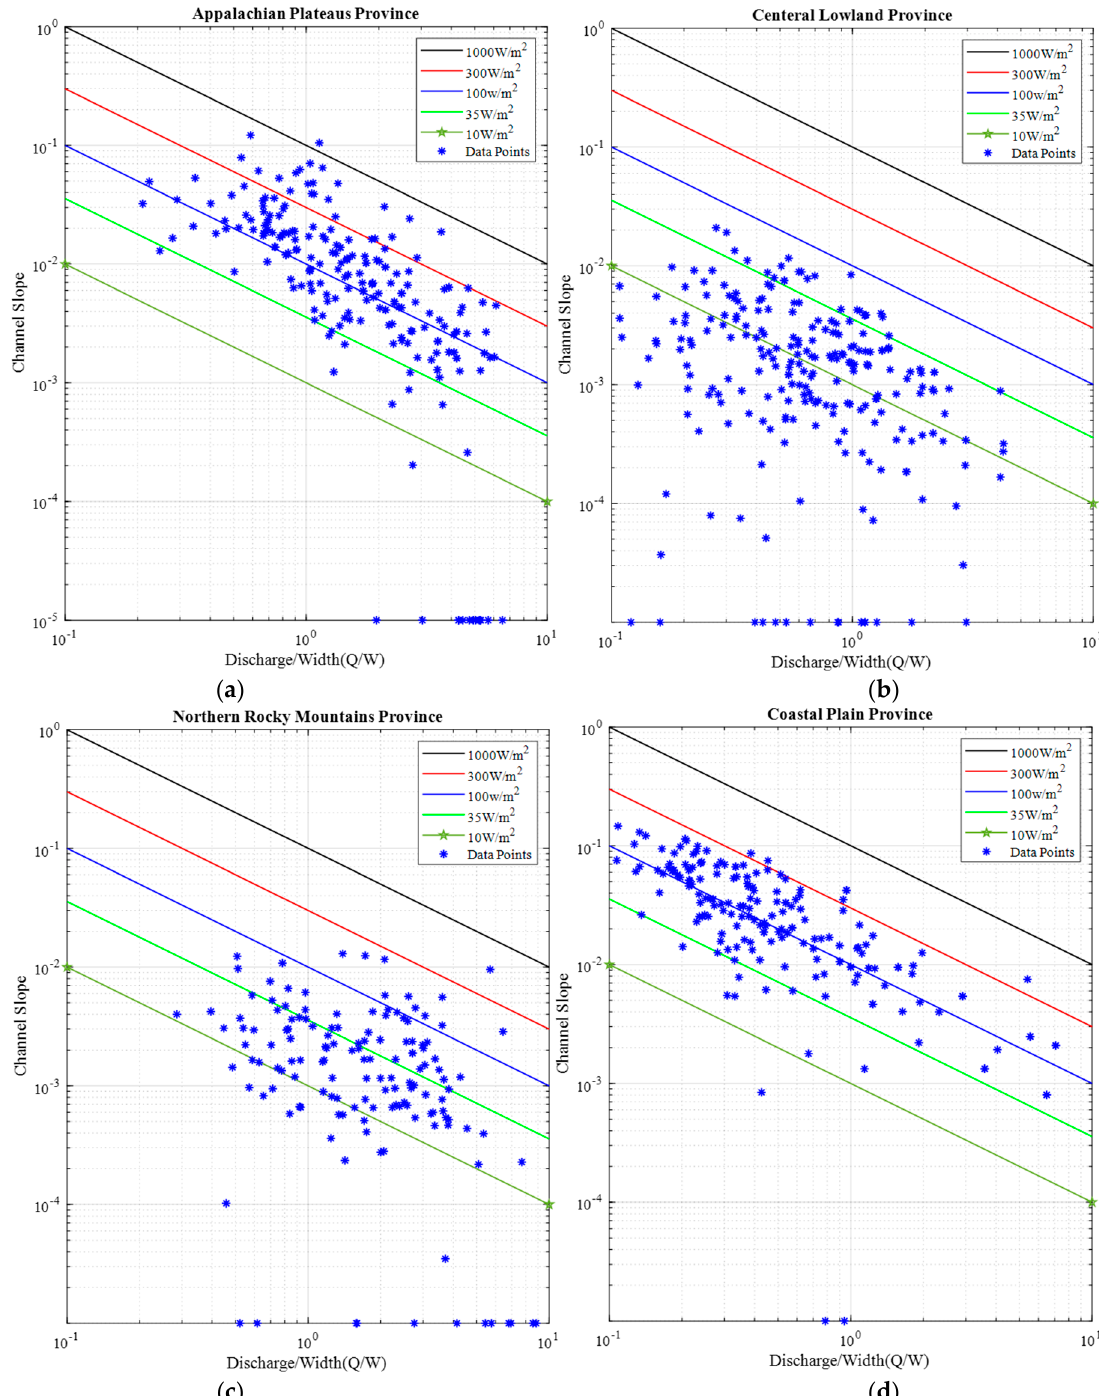
Figure 5. Stream power screening tool being applied for Physiographic Provinces with superimposed lines indicating stream power values: ( a ) Appalachian Plateaus Province, ( b ) Central Lowland Province, ( c ) Northern Rocky Mountain Province, ( d ) Coastal Plain Province.